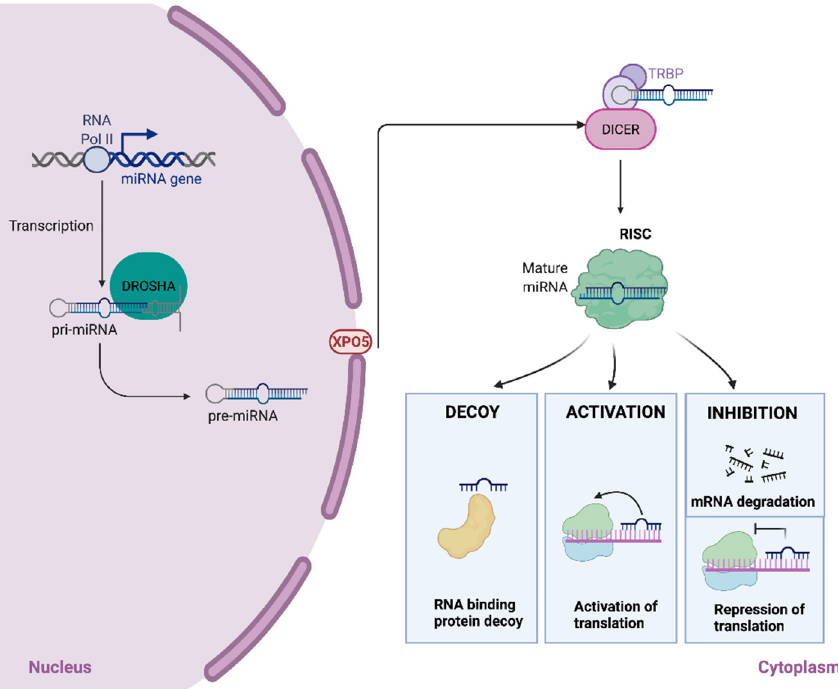
Figure 1. The biogenesis of microRNAs. MicroRNA genes are generally transcribed by RNA Poly- merase II in the nucleus to form large pri-miRNA transcripts, which are capped and polyadenylated. These pri-miRNA transcripts are processed by the RNase III enzyme Drosha to release the ~70-nucleotide pre-miRNA precursor product. Exportin 5 (XPO5) transports the pre-miRNA into the cytoplasm. Subsequently, another RNase III enzyme, Dicer, processes the pre-miRNA to generate a transient ~22-nucleotide miRNA: miRNA* duplex. This duplex is then loaded into the miRNA- associated multiprotein RNA-induced silencing complex (mi-RISC). The mature miRNA then binds to complementary sites in the target mRNA to induce an RNA-binding protein decoy, activation of translation, or inhibition of translation by mRNA degradation or translation repression. Created with